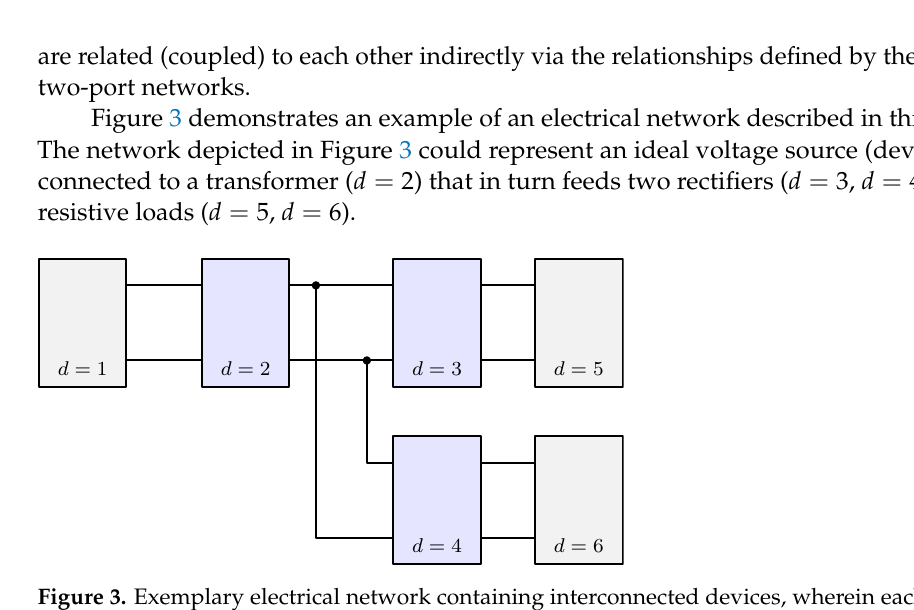
Figure 3. Exemplary electrical network containing interconnected devices, wherein each device is depicted as a one-port (gray) or two-port (blue) network.